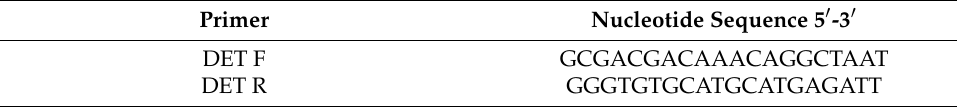
Table A1. Nucleotide sequence of primers used for mafbb mutants genotyping.